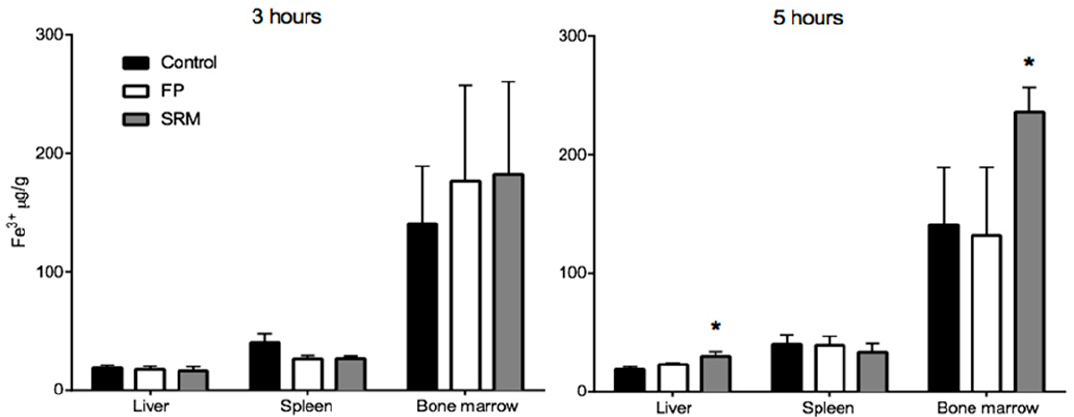
Figure 6. Quantity ( µ g) of Fe 3+ per gram of organ withdrawn from rats sacrificed after 3 or 5 h from the gavage. * p < 005. Means ± SD of at least six values obtained with different animals.